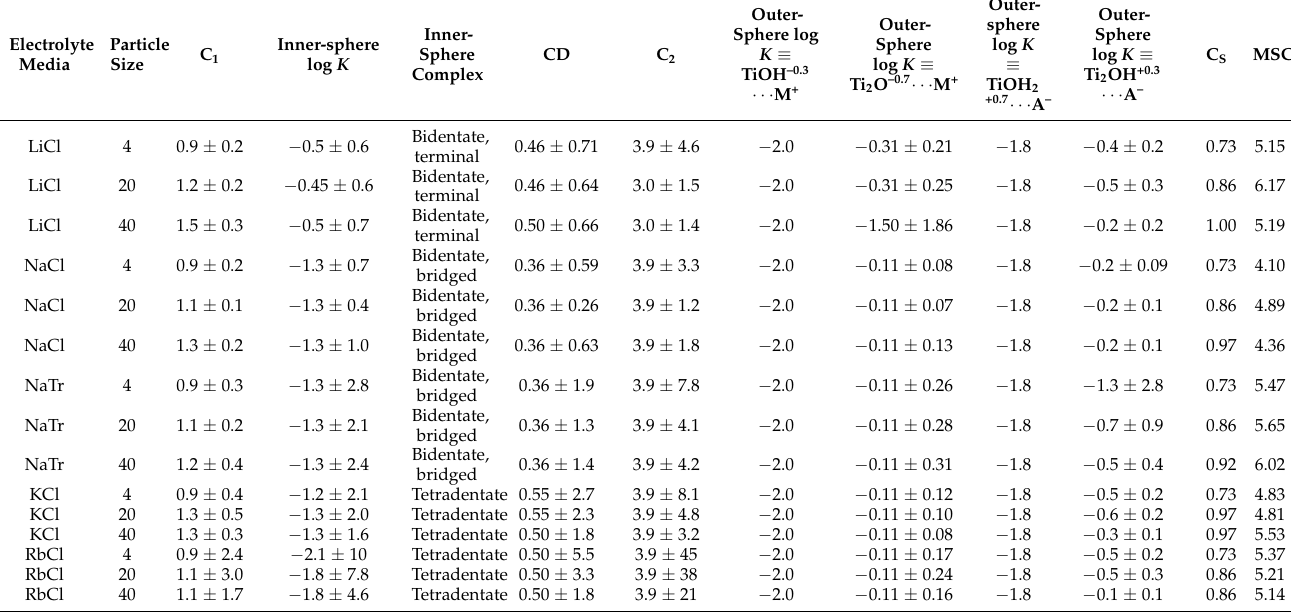
Table 2. Fitting parameters for the SCM for each anatase sample, in each electrolyte media. The particle sizes are in nm, capacitance values are in units of farad per m 2 ; also included are the MSC values 1